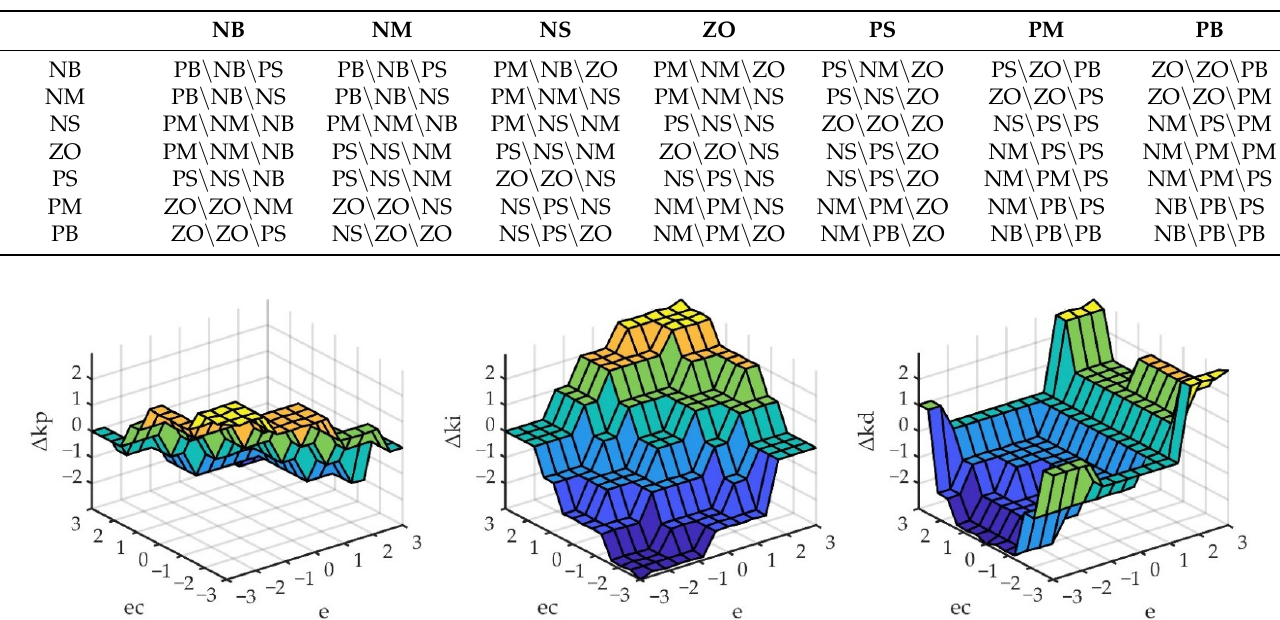
Table 2. Fuzzy inference rules table.